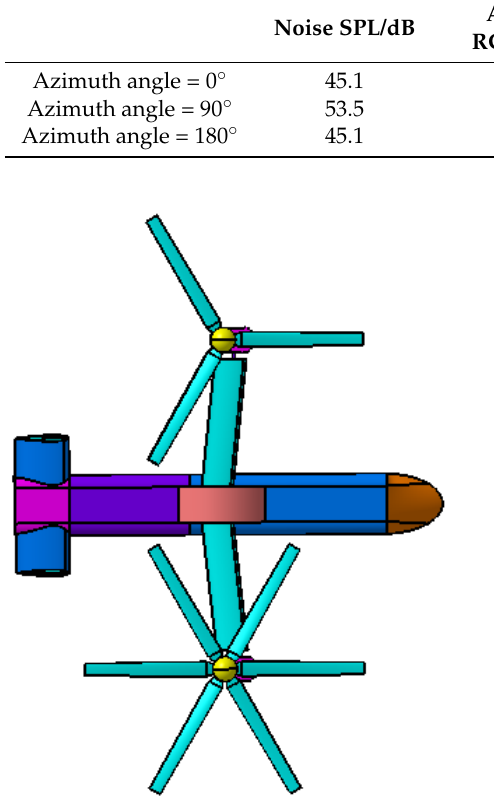
Figure 24. View of a coaxial tilt-rotor aircraft with PPC3. Table 22. Noise SPL and average RCS values with PPC3.